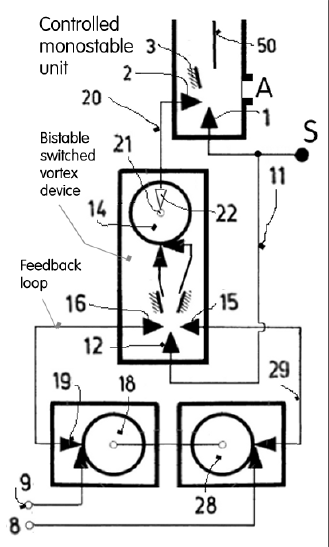
Fig. 15. Fluidic circuit diagram of the PWM controller for the terminal unit shown in Figs 13 and 14. The central device, Coanda-switched vortex amplifier, operates on the principle presented in Fig. 2C. Numbers correspond to [9] and to Figs. 13 and 14.